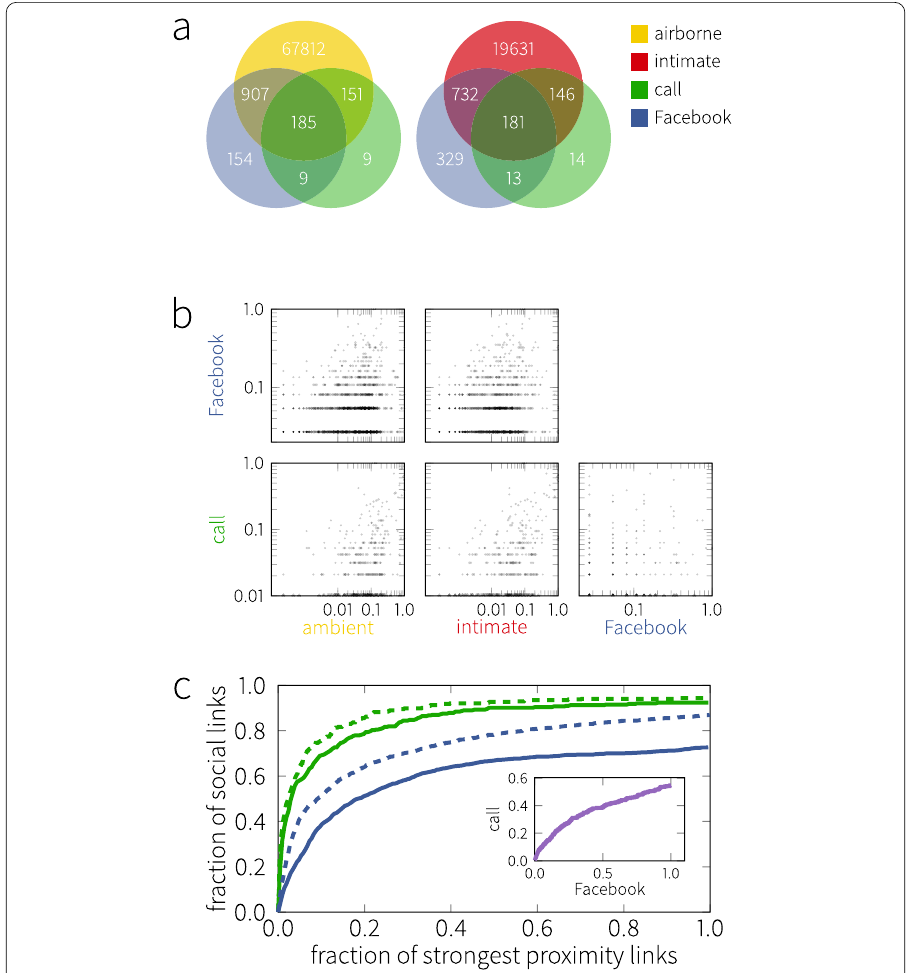
Figure 1 Comparison of link sets in the three networks. (a) Venn diagrams showing the number of links in the different channels: ambient (left), intimate (right). Color code is given on the right. (b) Correlation of link weight between the channels in log-log scale. Weight is defined by the number of contacts taking place on the links, normalized by the maximum observed value. (c) Fraction of social links recovered by the strongest ambient (dashed) and intimate (solid) physical proximity links: calls (green) and Facebook (blue). Inset shows the coverage of call links by Facebook